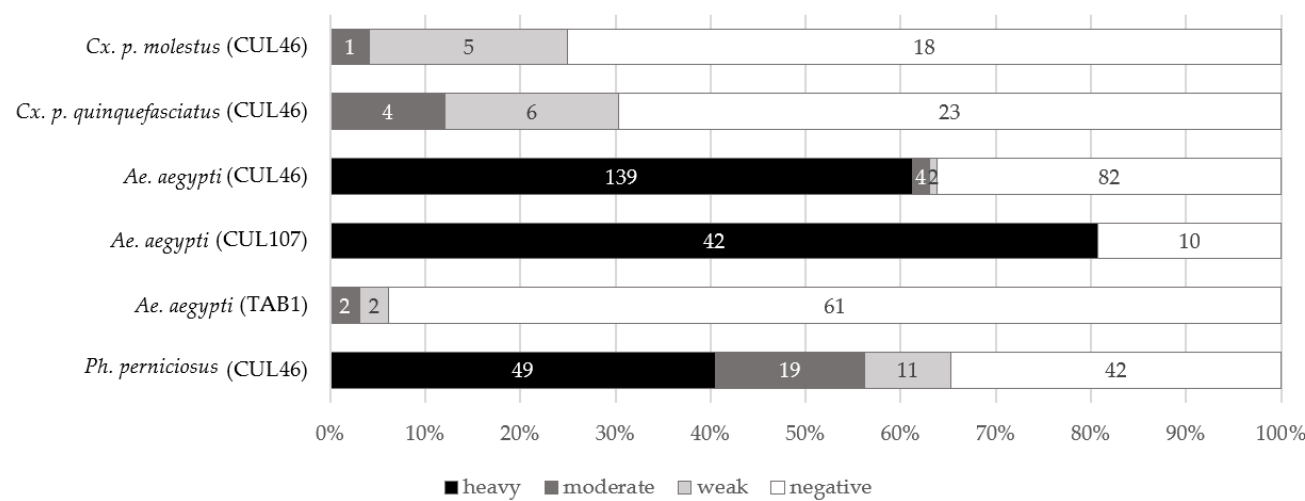
Figure 3. T. theileri prevalence in experimentally infected mosquitoes and sandflies. Prevalence for Culex spp. is shown for low-temperature experiments only.